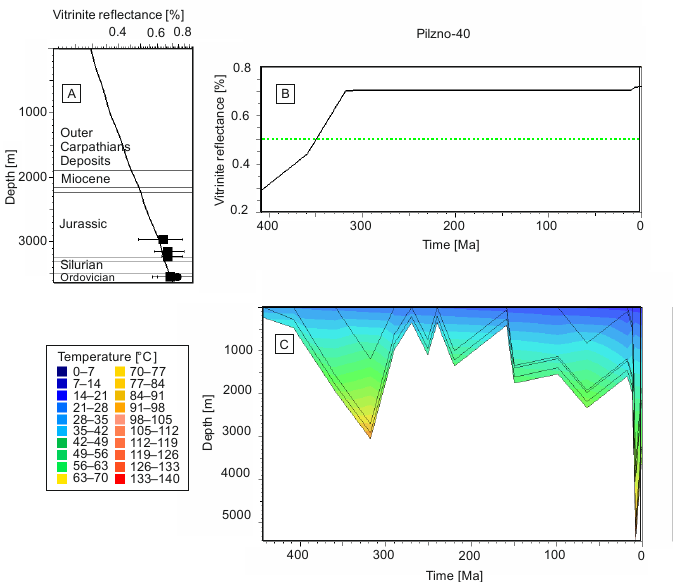
Figure 6. Burial and thermal history model (no. 2) for the Pilzno-40 well assuming Late Miocene overthrusting of the Outer Carpathians but with Variscan burial heating: ( A ) calibration of the model by comparison between measured VR values and the calculated VR curve; ( B ) VR evolution with time showing a major increase in the Devonian–Carboniferous, whereas the Miocene overprint is not particularly important. The green dash line is the VR value equals 0.5% that represents border between immature and mature kerogen; ( C ) burial history curves with temperature overlay. Note the temperature increase, first in the Carboniferous, and later in the Late Miocene.